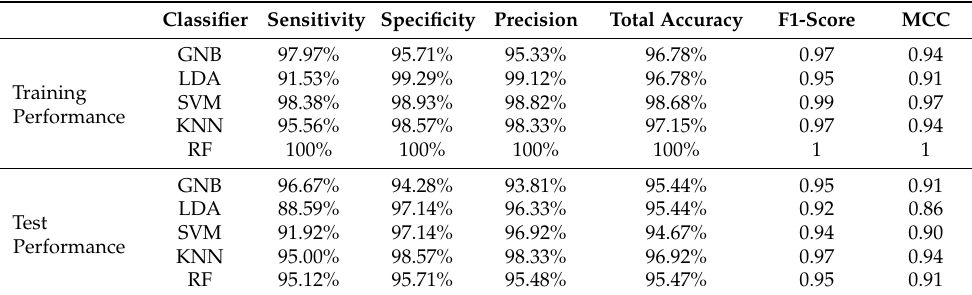
Table 3. Classification performance of different classifiers discriminating 62 SCZ from 70 HC subjects using 5-fold CN-CV.